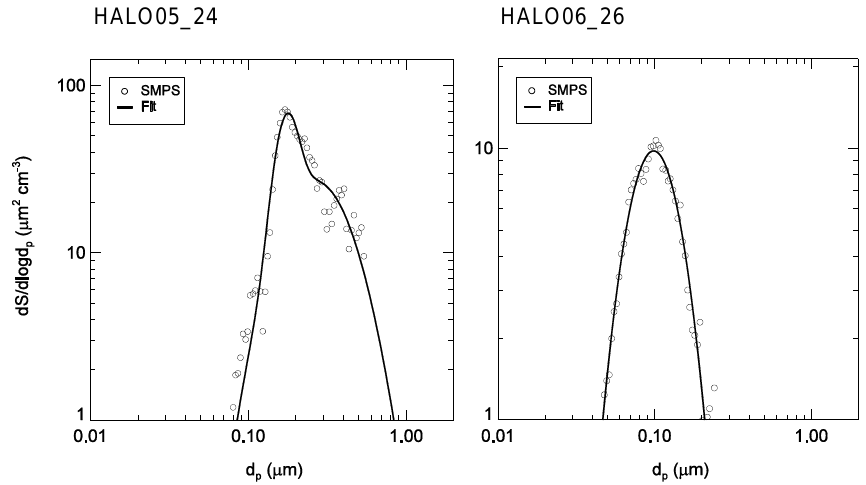
Fig. 2. Aerosol surface size distributions for the experiments HALO05 24 with hematite #1 aerosol and HALO06 26 with GSG soot aerosol. The surface size distributions are inferred from number size distributions as measured by a scanning mobility particle sizer SMPS. Lognormal fits (solid lines) are applied to the measurement data (open symbols), bimodal for the hematite aerosol (monomers and agglomerates), and monomodal for the graphite spark generator soot aerosol.